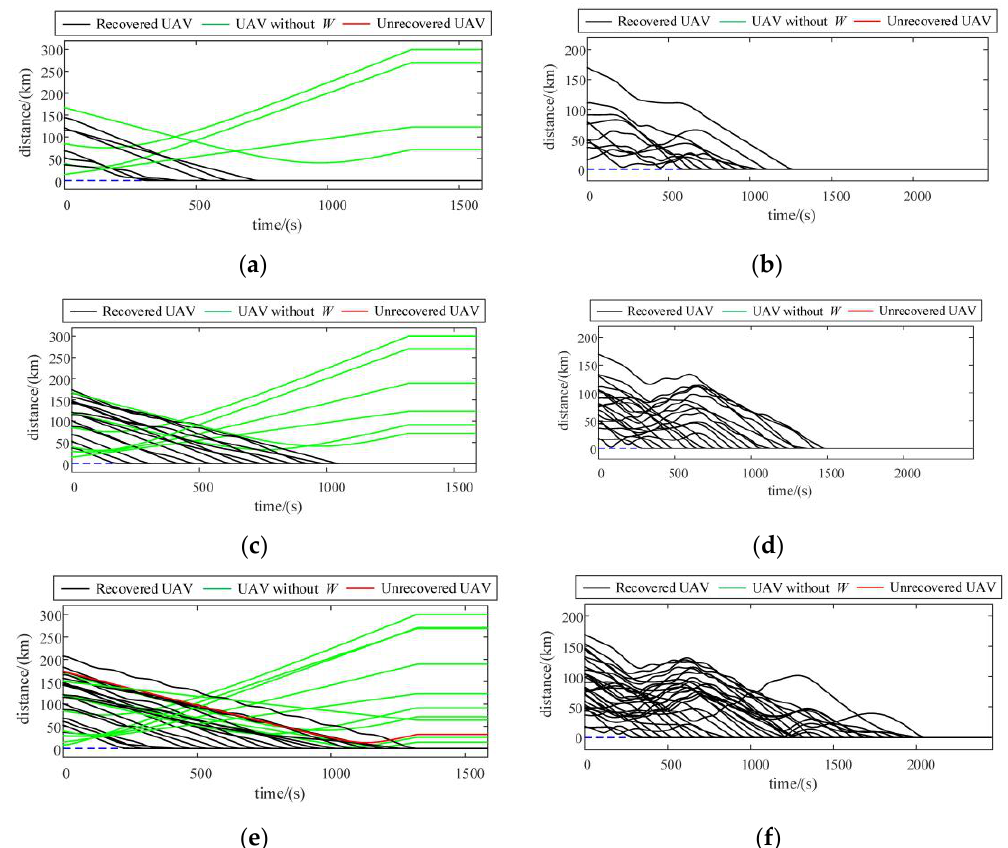
Figure 11. Representative recovery results. ( a ) 10 UAVs with a non-maneuvering mother aircraft; ( b ) 10 UAVs with a maneuvering mother aircraft; ( c ) 20 UAVs with a non-maneuvering mother aircraft; ( d ) 20 UAVs with a maneuvering mother aircraft; ( e ) 30 UAVs with a non-maneuvering mother aircraft; ( f ) 30 UAVs with a maneuvering mother aircraft.